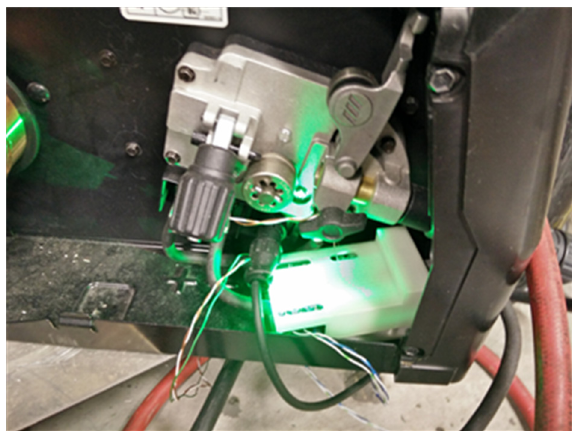
Figure 3. Installed current and voltage measurement circuit in the Millermatic 190 gas metal arc welder with 3-D printed cover